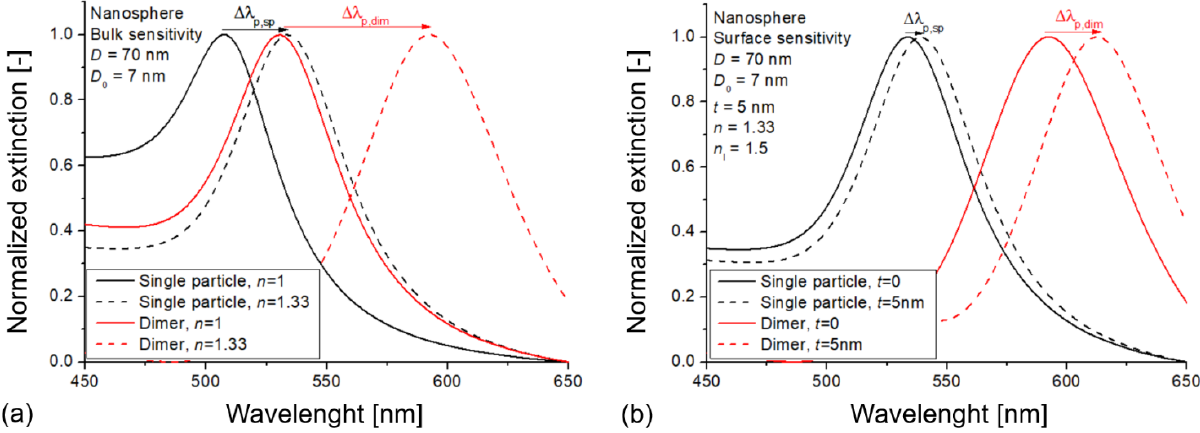
Figure 2. Normalized extinction spectra simulated on single-particle and dimer arrangements of gold nanospheres to illustrate the changes in bulk RI sensitivity ( a ) and surface sensitivity ( b ) caused by plasmonic coupling between the nanospheres. For the illustration of the different conditions, please see Figure 1.